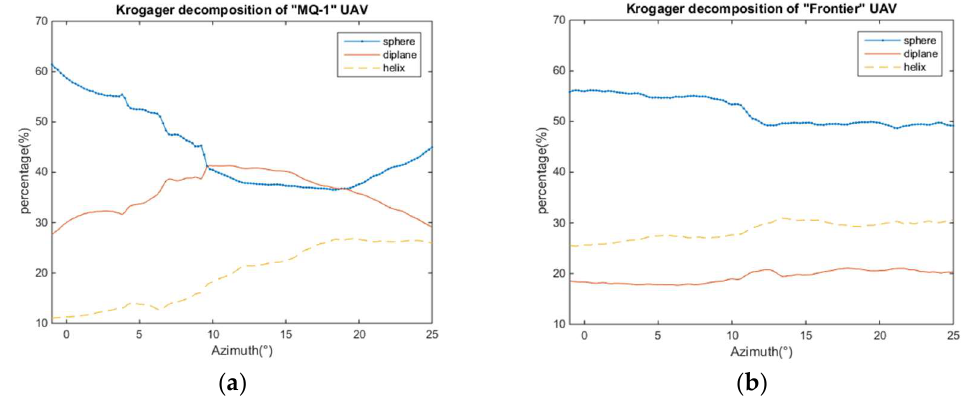
Figure 12. The proportions of the scattering mechanisms of Krogager decomposition of “MQ-1” and “Frontier” UAVs. ( a ) “MQ-1” UAV; ( b ) “Frontier” UAV.